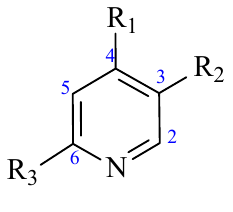
Figure 1. Chemical structures of compounds 1 – 4